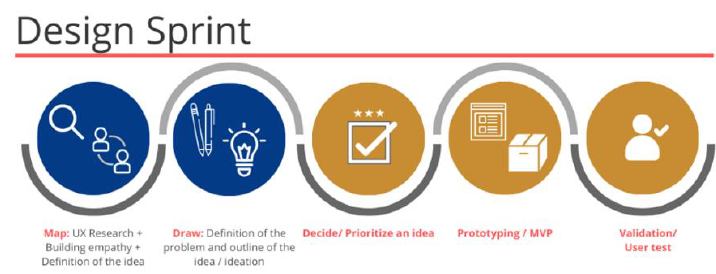
Figure 2. Design Sprint processes [elaborated by authors].